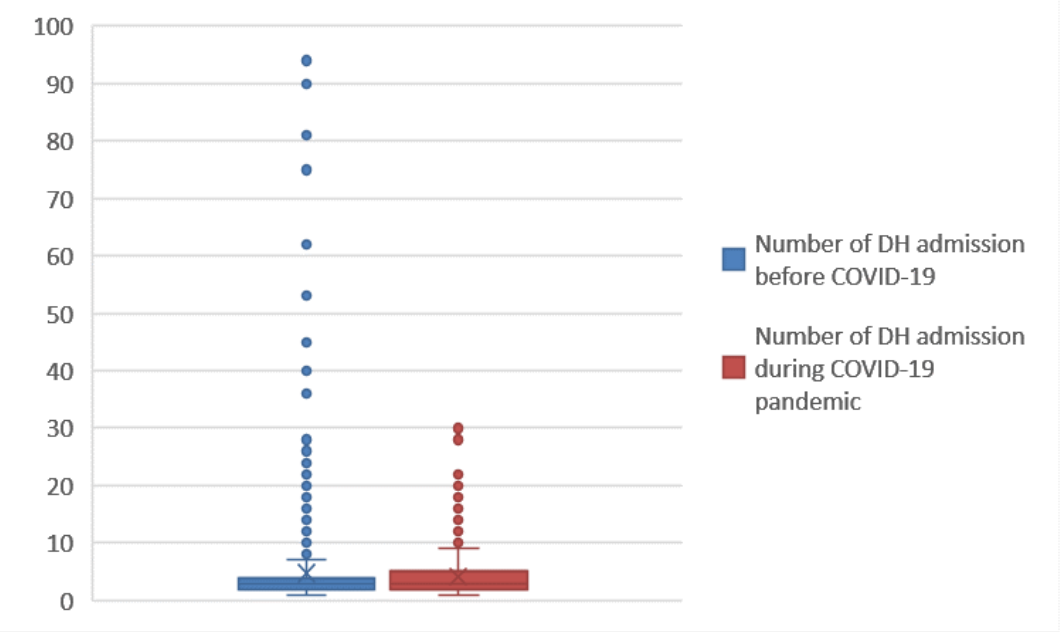
Figure 10. Box plot of number of DH admissions (2018 – 2019 vs. 2020 – 2021).